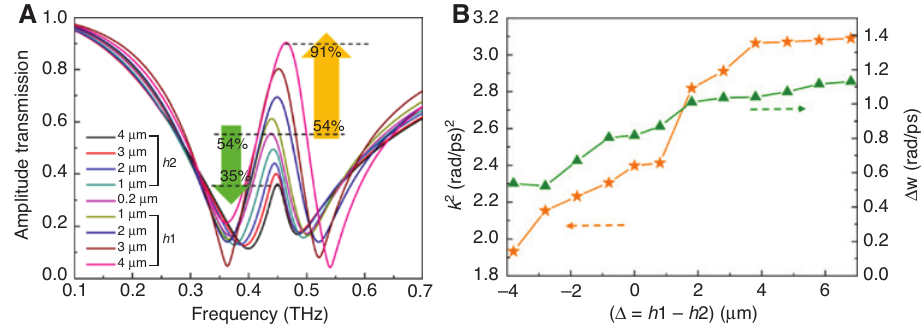
Figure 6: Fitting results. (A) The transmission spectrum with various heights of the IRR and OSRR. (B) The coupling coefficient κ and linewidth with various height differences Δ .